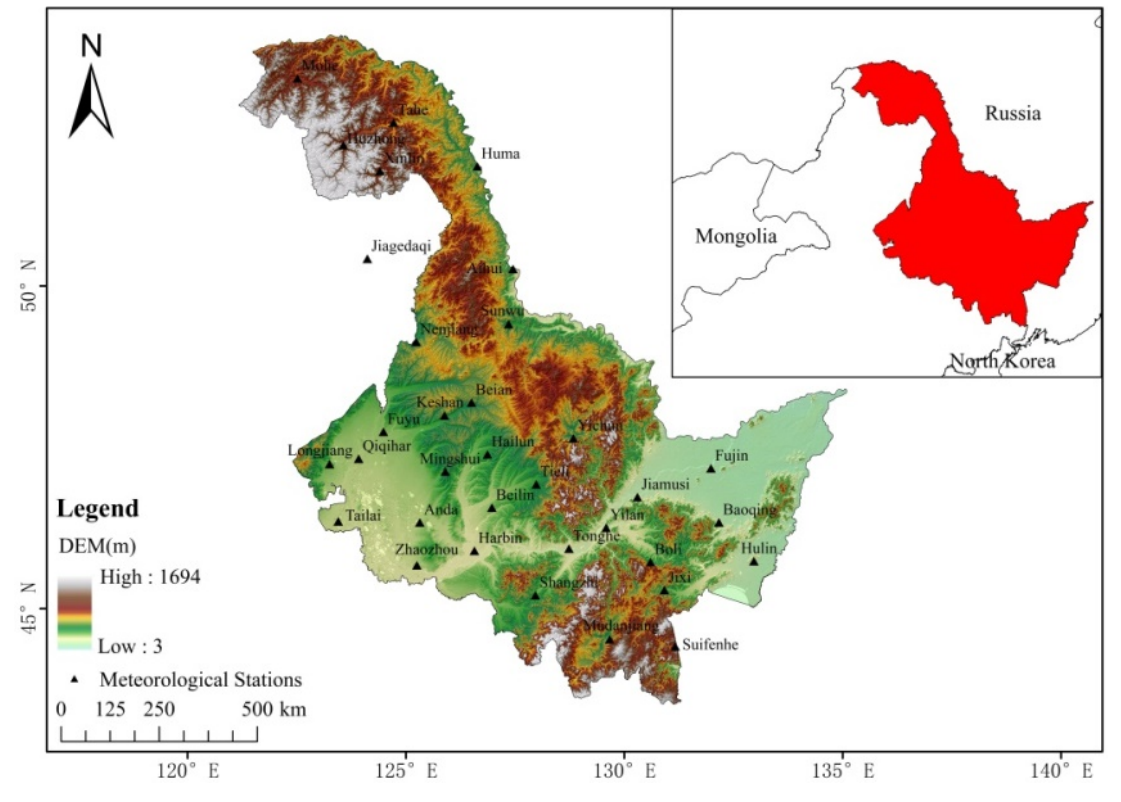
Figure 1. Study area and distribution of meteorological stations.